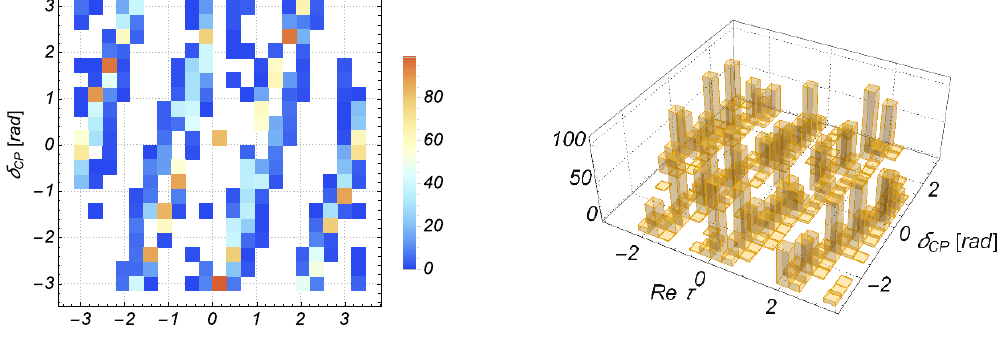
Figure 8 . Distributions of the CP-violating phase δ CP vs. real part of complex structure modulus Re τ for Im τ = 1 . 9 in Pattern II.